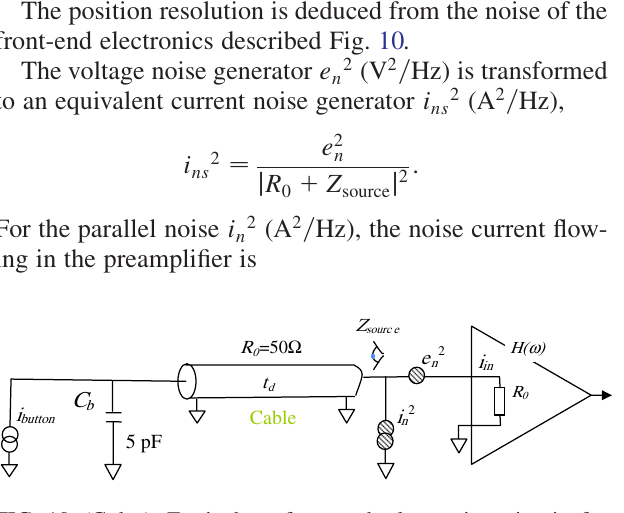
FIG. 10. (Color) Equivalent front-end electronics circuit for and e are parallel and series sources of the noise analysis. i n n noise. H ð ! Þ is the transfer function of the